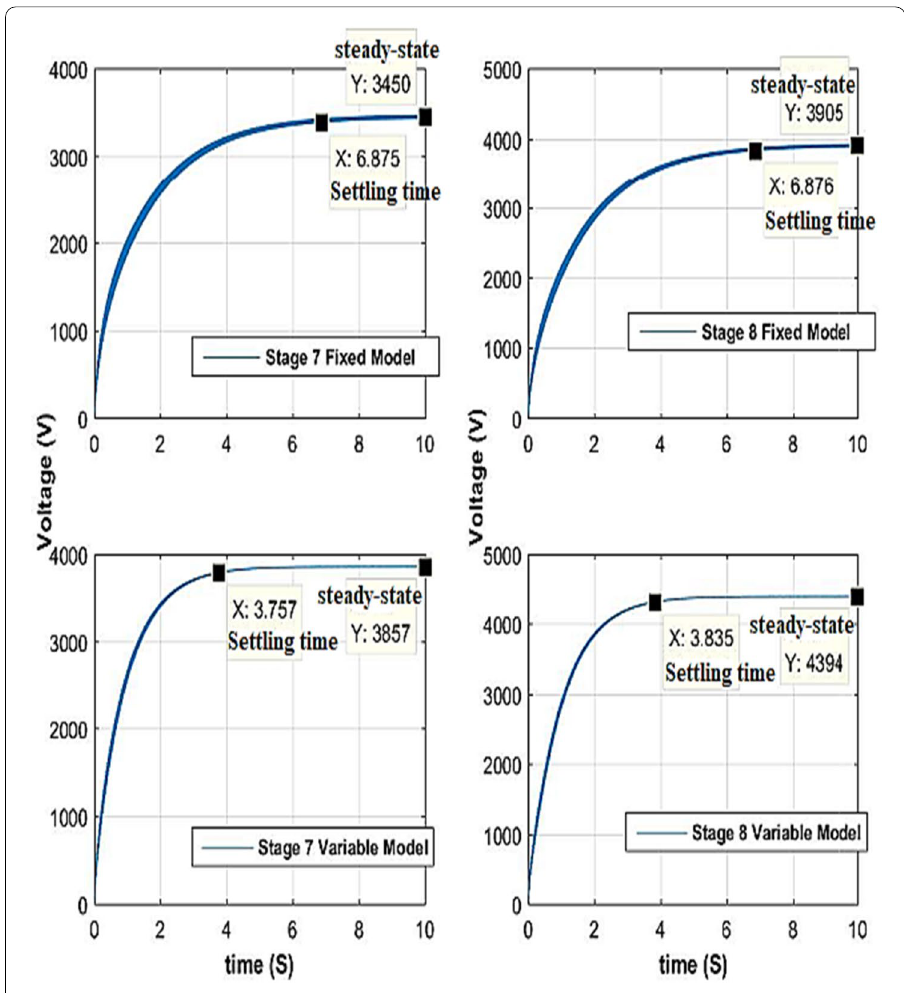
Fig. 11 Settling time, transient and steady state value of output voltage of stage one and two of both